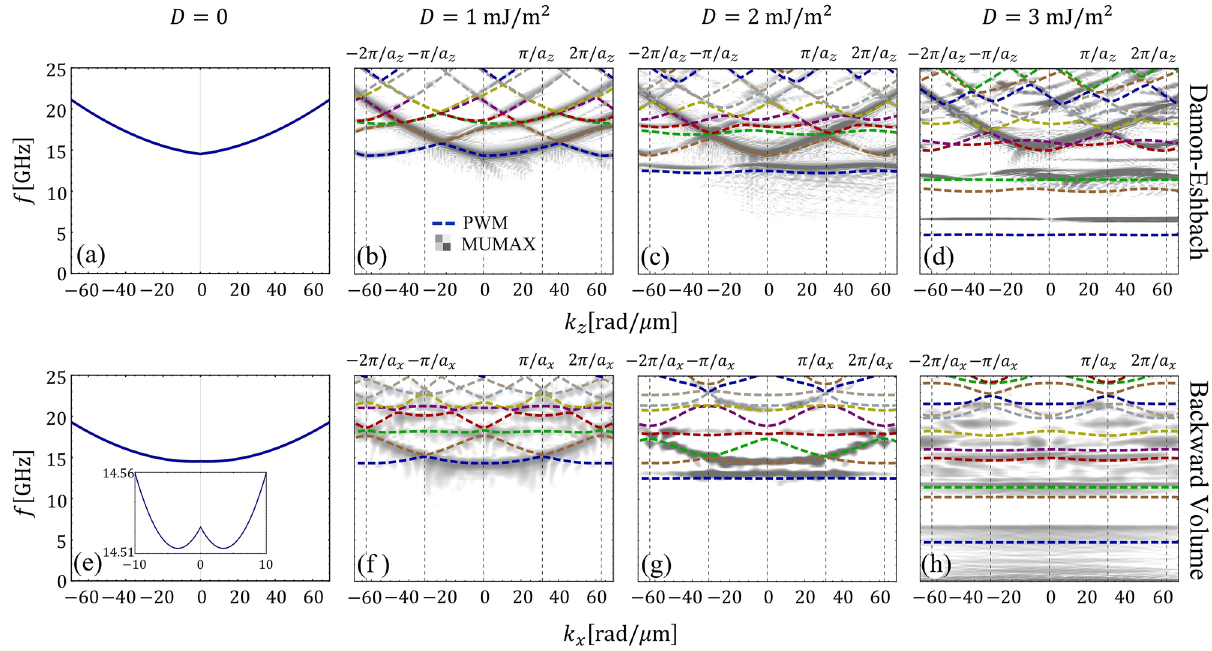
Figure 2. Magnonic band structure for an ultrathin film in contact with an array of square heavy-metal islands with period a z = a x = 100 nm and w z = w x = 50 nm. ( a – d ) Shows the Damon–Eshbach case and ( e – h ) the backward volume configuration, for D = 0, 1, 2 and 3 mJ/m 2 . The inset in ( e ) depicts the typical SW dispersion of the backward volume geometry, wherein the mode exhibits two minima at finite wave vectors. The dashed lines correspond to the calculations and the gray code to the micromagnetic simulation.